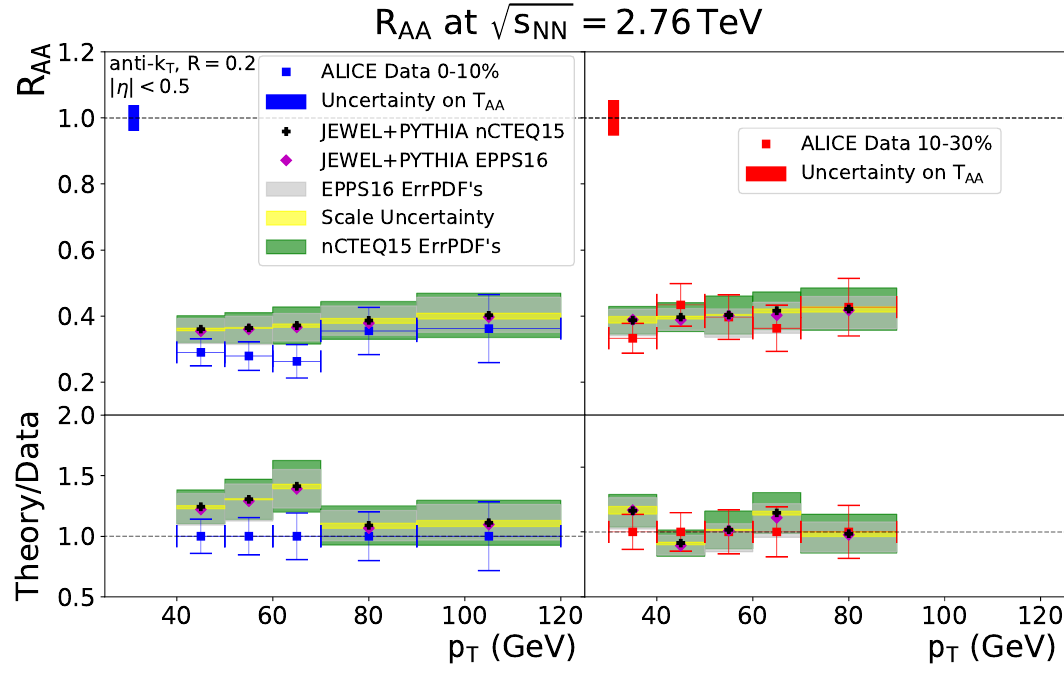
√ s NN = 2 . 76 TeV is indicated AA